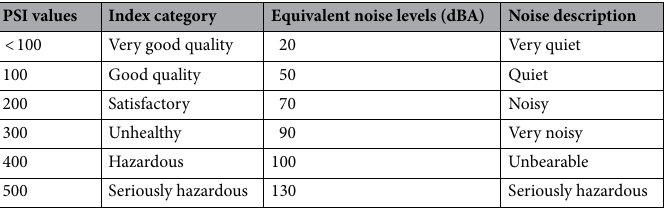
Table 2. Standard Index for noise measurements incorporating PSI values as well as equivalent noise